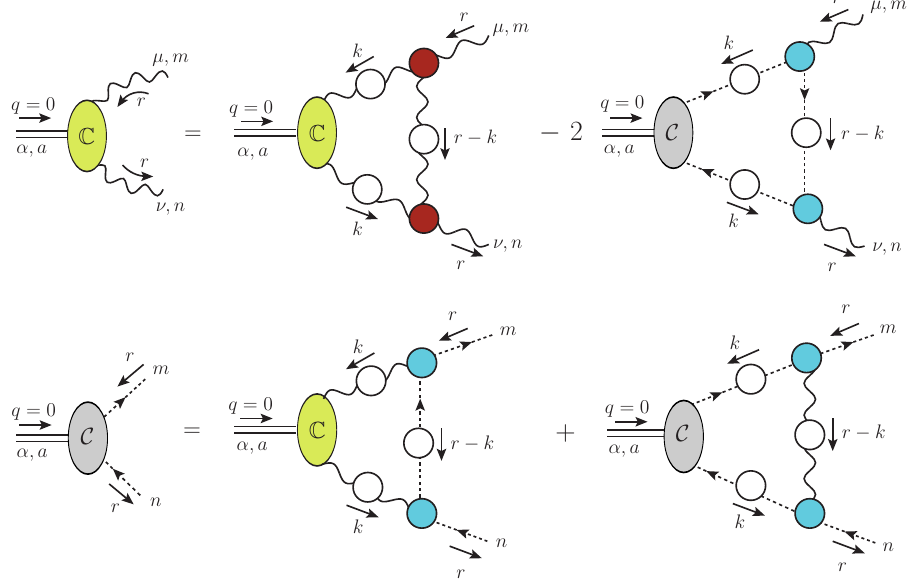
Figure 6. The diagrammatic representation of the coupled system of Bethe–Salpeter equations (BSEs) that governs the evolution of the functions C ( r 2 ) and